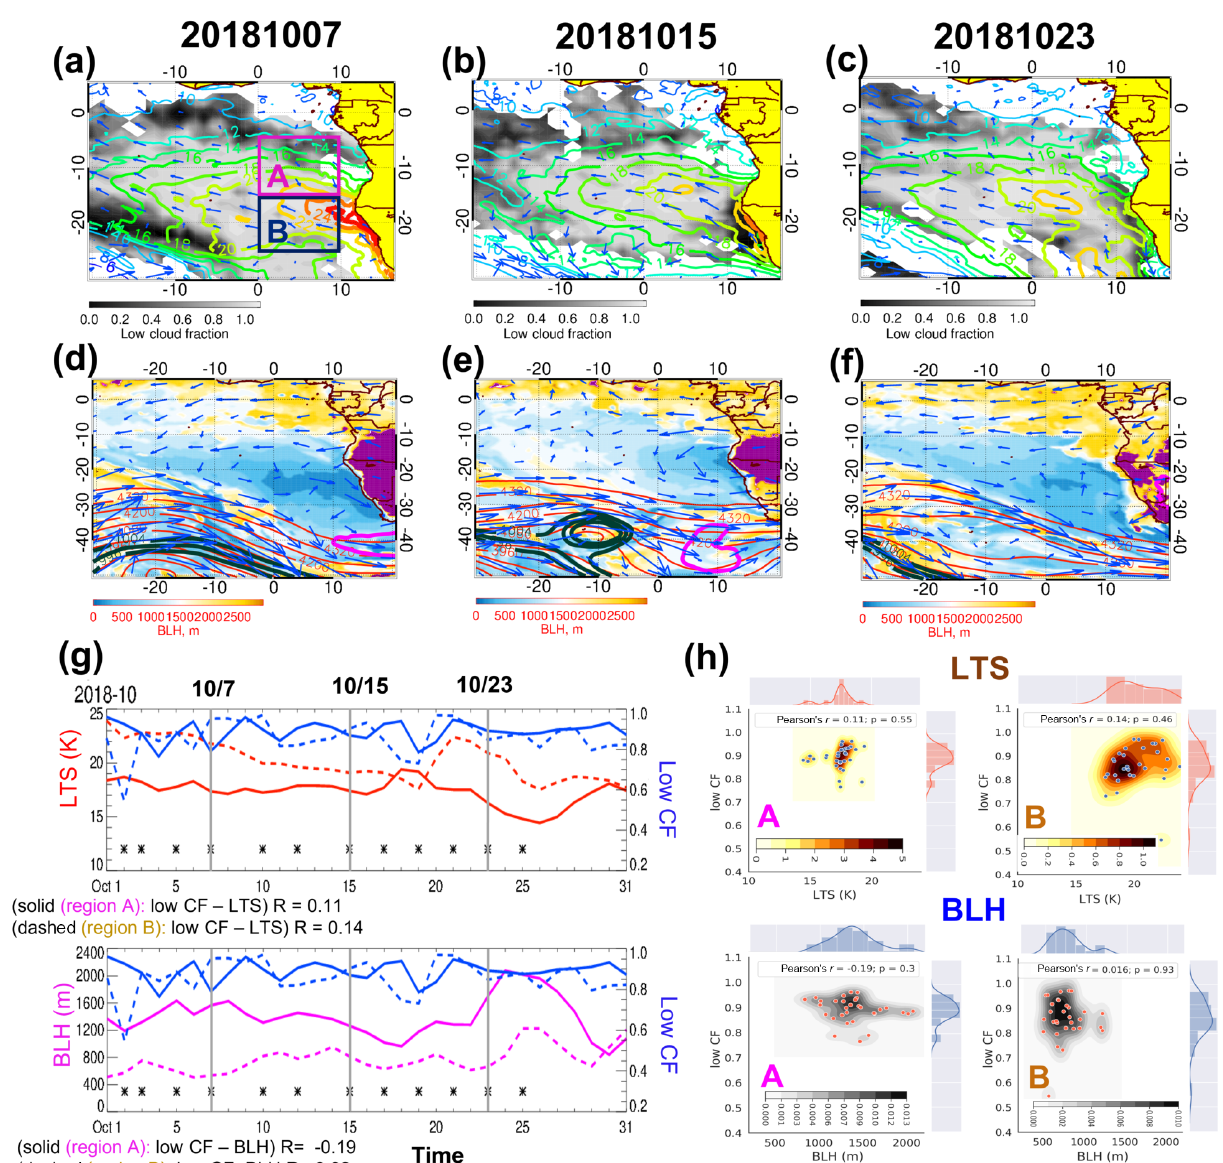
Figure 16. Map of (a–c) daily mean low CF (shading) overlaid by LTS (contour; K) and 925hPa horizontal winds (vectors; ms − 1 ), (d– f) BLH (shading; m) overlaid by 600hPa horizontal winds (vectors; ms − 1 ), 600hPa geopotential height (red lines; m), and sea level pressure (SLP; lines in dark green for low pressure at 996, 1000, and 1004 and in magenta for high pressure at 1024, 1028, and 1032; hPa) at 12:00UTC on 7, 15, and 23 October 2018. (g) Top plot shows the time series of daily mean low CF (blue lines) and daily mean LTS (red lines; K), and the bottom plot shows the daily mean low CF (blue lines) and daily mean BLH (magenta lines; m) averaged over region A (0–10 ◦ E, 5–15 ◦ S; solid lines) and region B (0–10 ◦ E, 15–25 ◦ S; dashed lines) during October 2018. All flight days (7, 15, and 23 October 2018) are marked by an asterisk (gray vertical lines). The purple shading over the land in panels (d) – (f) refers to BLH higher than 3250m. (h) The 2-D joint pdf (shading) with a scatterplot are shown with 1-D histogram (pdf in line) of (top) low CF and LTS and (bottom) daily mean low CF and BLH over region A (left) and B (right) during October 2018. The solid line in panel (a) indicates region A (magenta box) and region B (navy box), respectively. The Pearson’s r in panel (h) refers to Pearson correlation coefficient with its statistical significance ( p value).